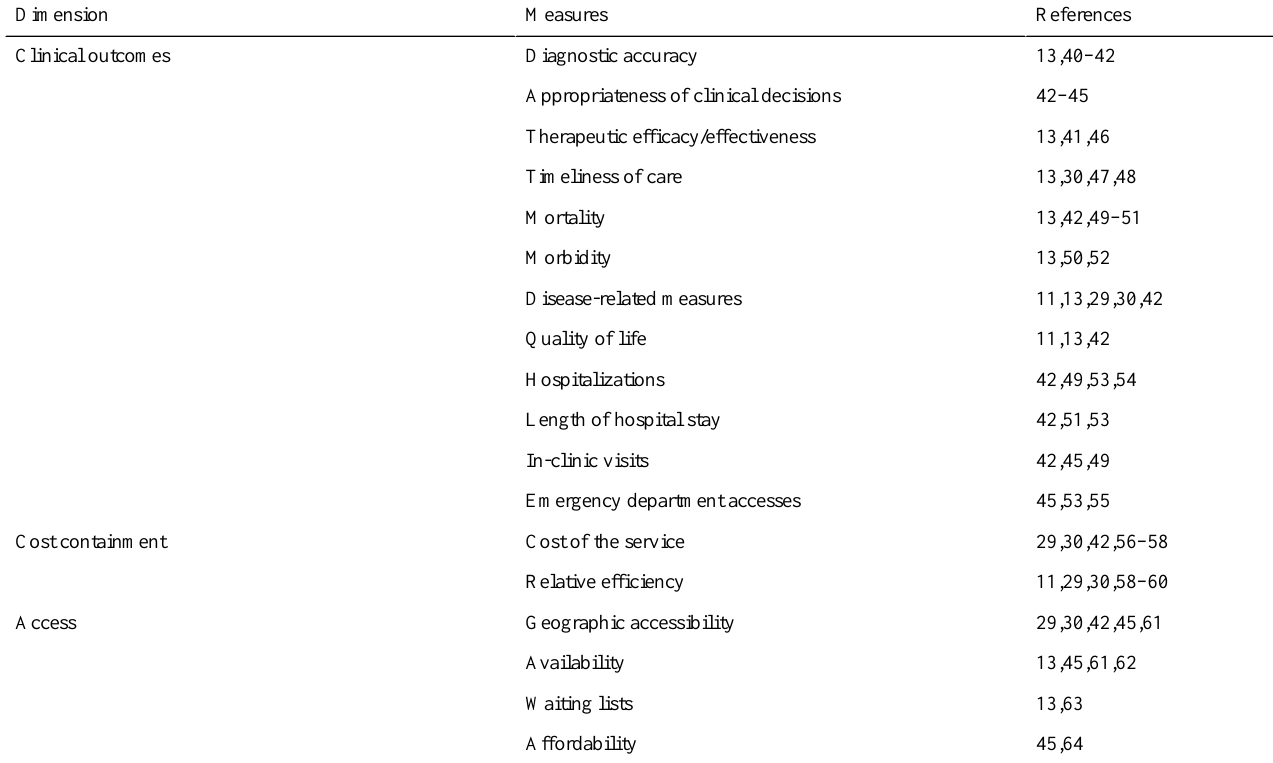
Table 1. Benefits-related